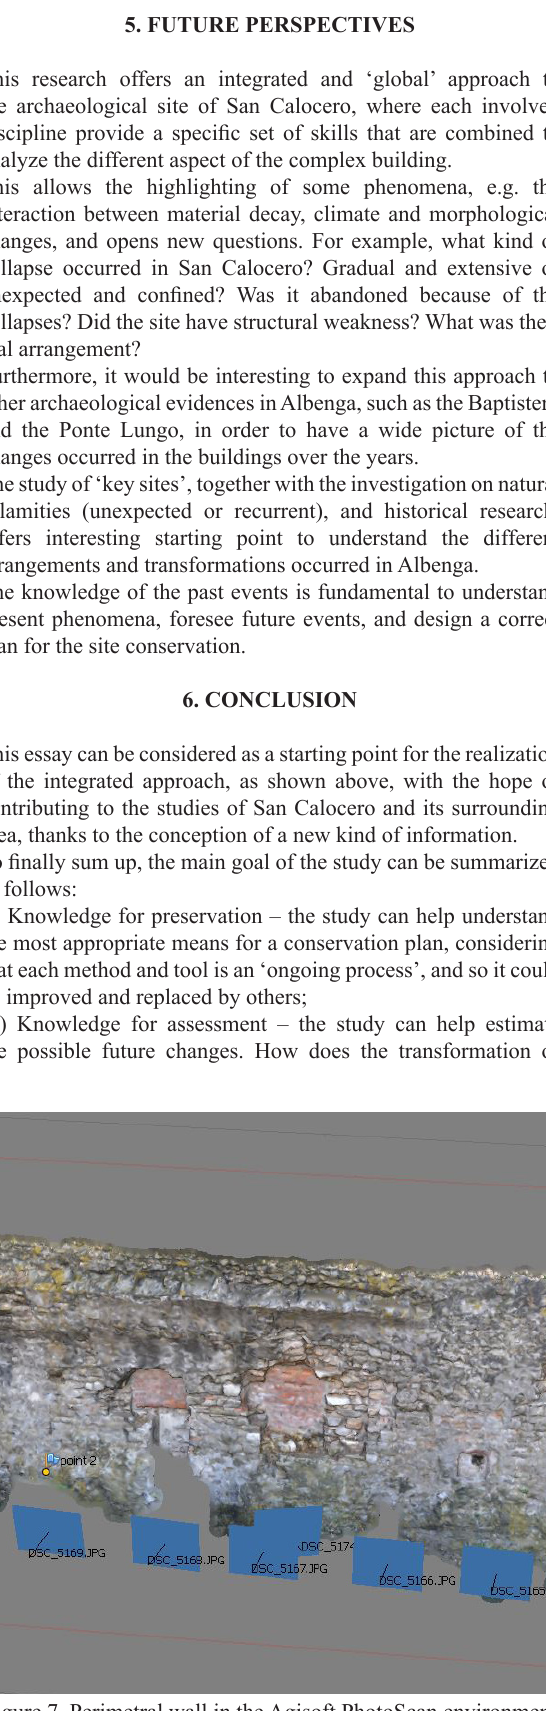
during the last survey